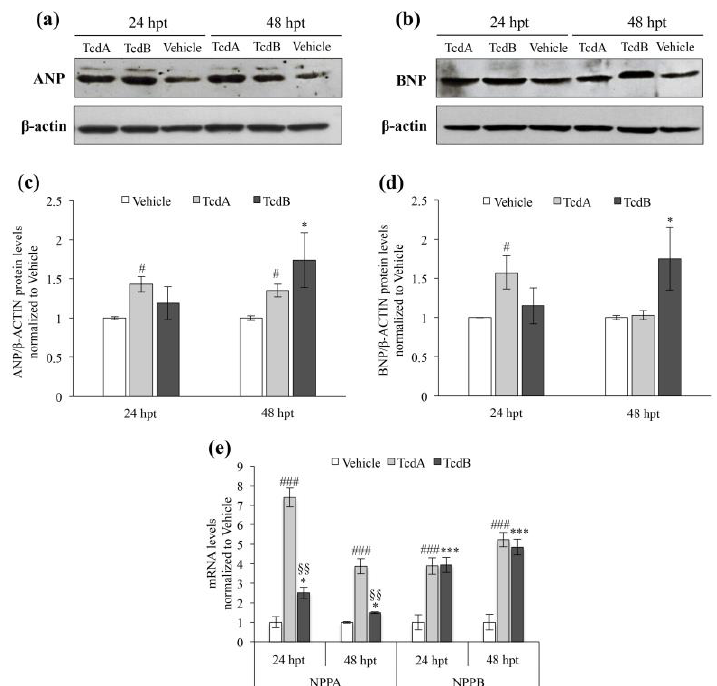
Figure 3. Cardiac hypertrophy markers analysis confirms the early role of TcdA in inducing heart damage compared to TcdB in zebrafish embryos. ( a ) Representative Western blot analysis for Atrial Natriuretic Factor (ANP) in vehicle, 2.5 µ g / mL TcdA- or 8 µ g / mL TcdB-treated embryos after 24 and 48 h. Actin is used to verify protein loading. ( b ) Representative Western blot analysis for Brain Natriuretic Peptide (BNP) in vehicle, 2.5 µ g / mL TcdA- or 8 µ g / mL TcdB-treated embryos at 24 and 48 h. Actin is used to verify protein loading. ( c ) Densitometric analysis of ANP protein in embryos treated with vehicle, 2.5 µ g / mL TcdA or 8 µ g / mL TcdB. Data, normalized to β -actin, are expressed